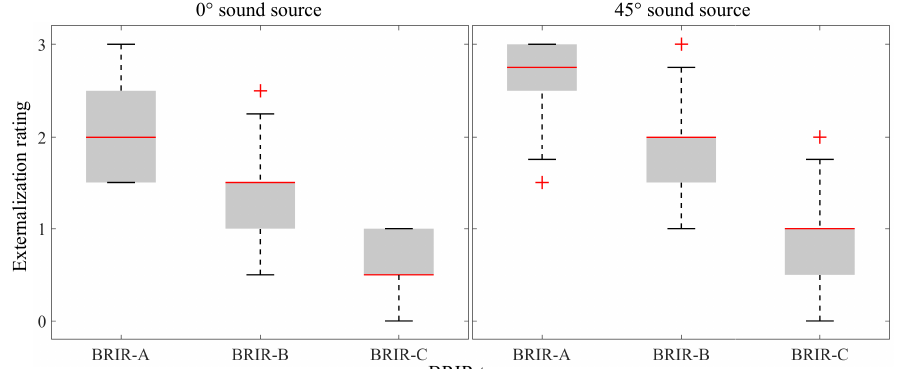
Figure 4. Box plot of externalization ratings for stimuli generated with different BRIR types in Experiment I. The left and right panels show the externalization results for 0° and 45° sound sources, respectively. The median externalization ratings (red lines), 25th and 75th percentiles (bottom and top edges of the boxes), whiskers (1.5 × interquartile range) and outliers (red crosses) are shown in the